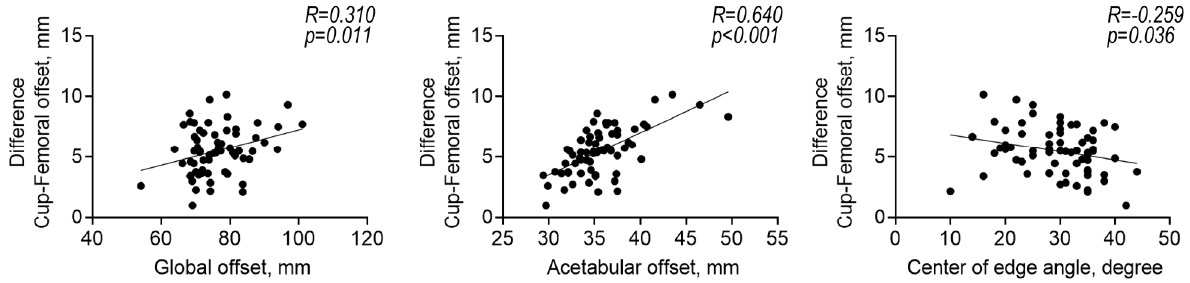
Figure 6. Correlations among the radiographic parameters and the difference between the cup and femoral offsets.